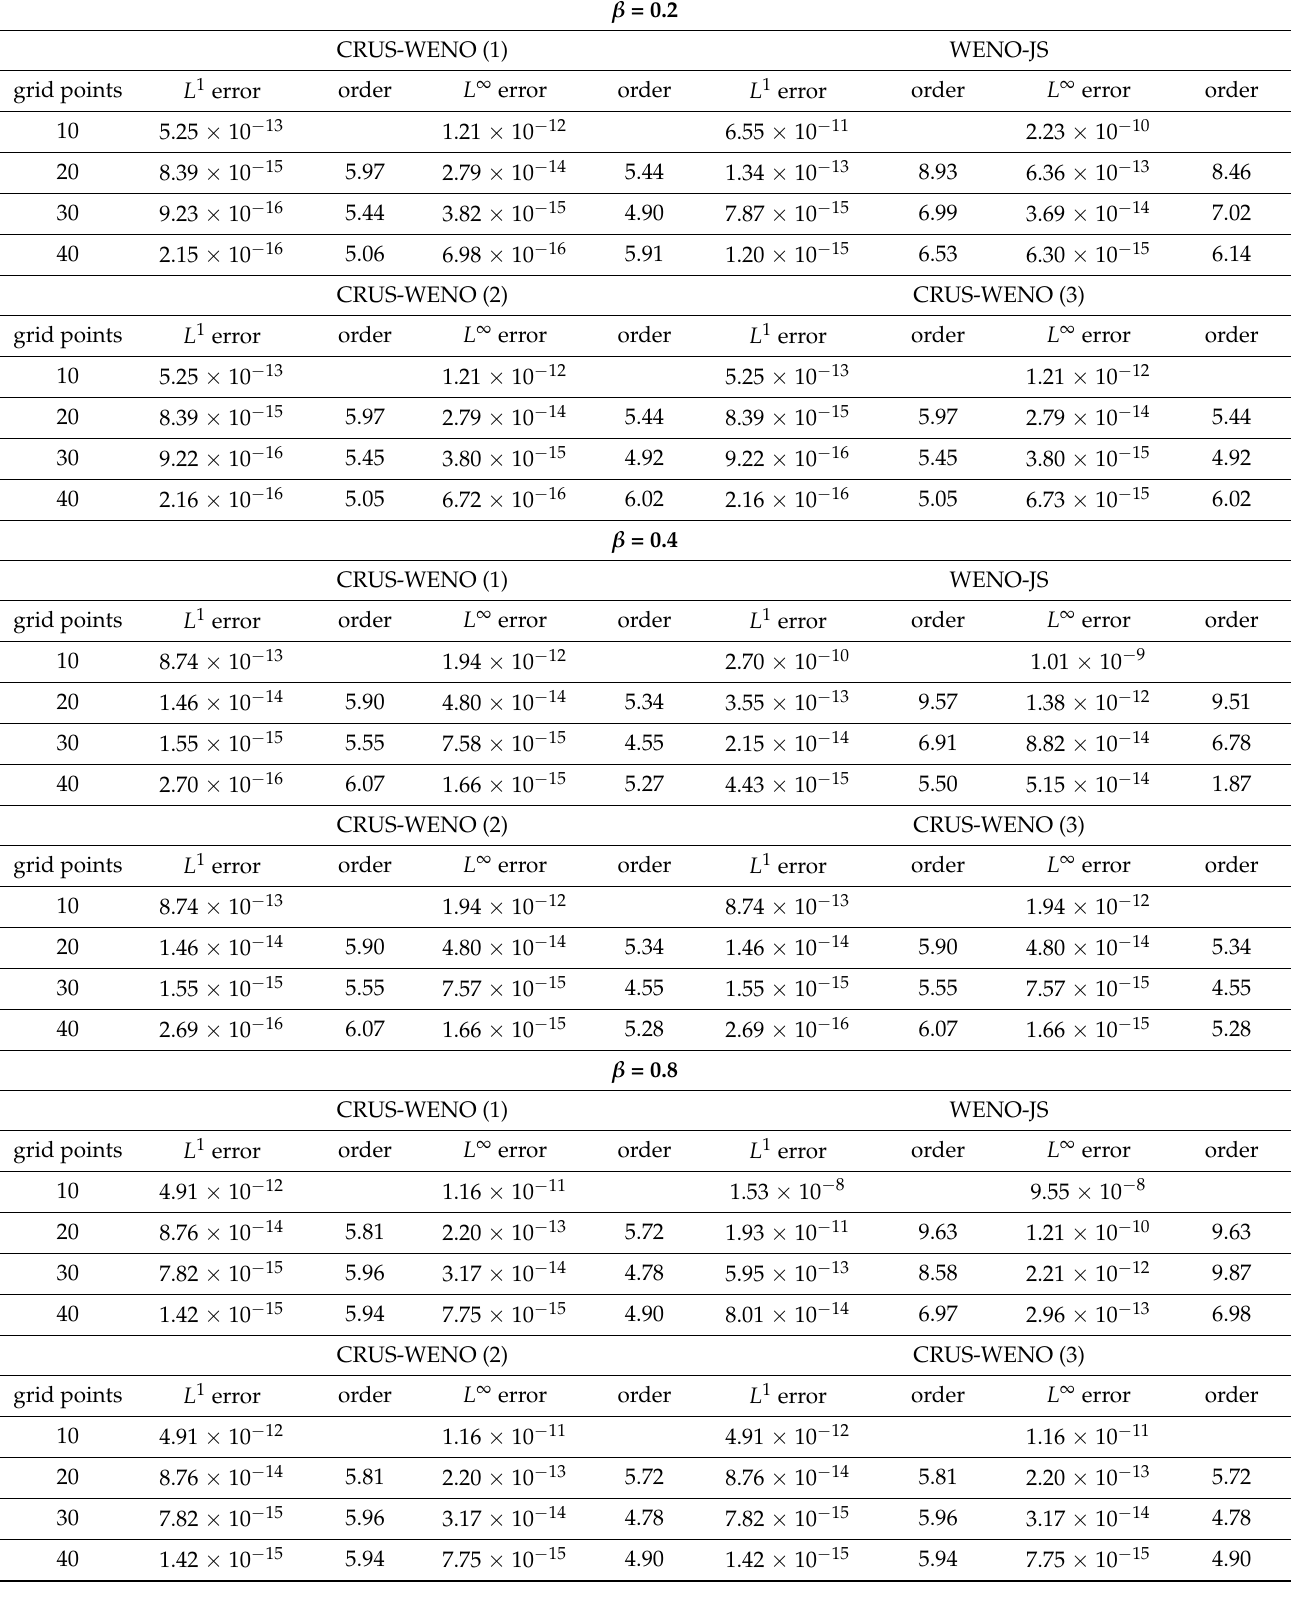
Table 1. The errors and orders of the accuracy of Example 1 at t = 0.1. β =